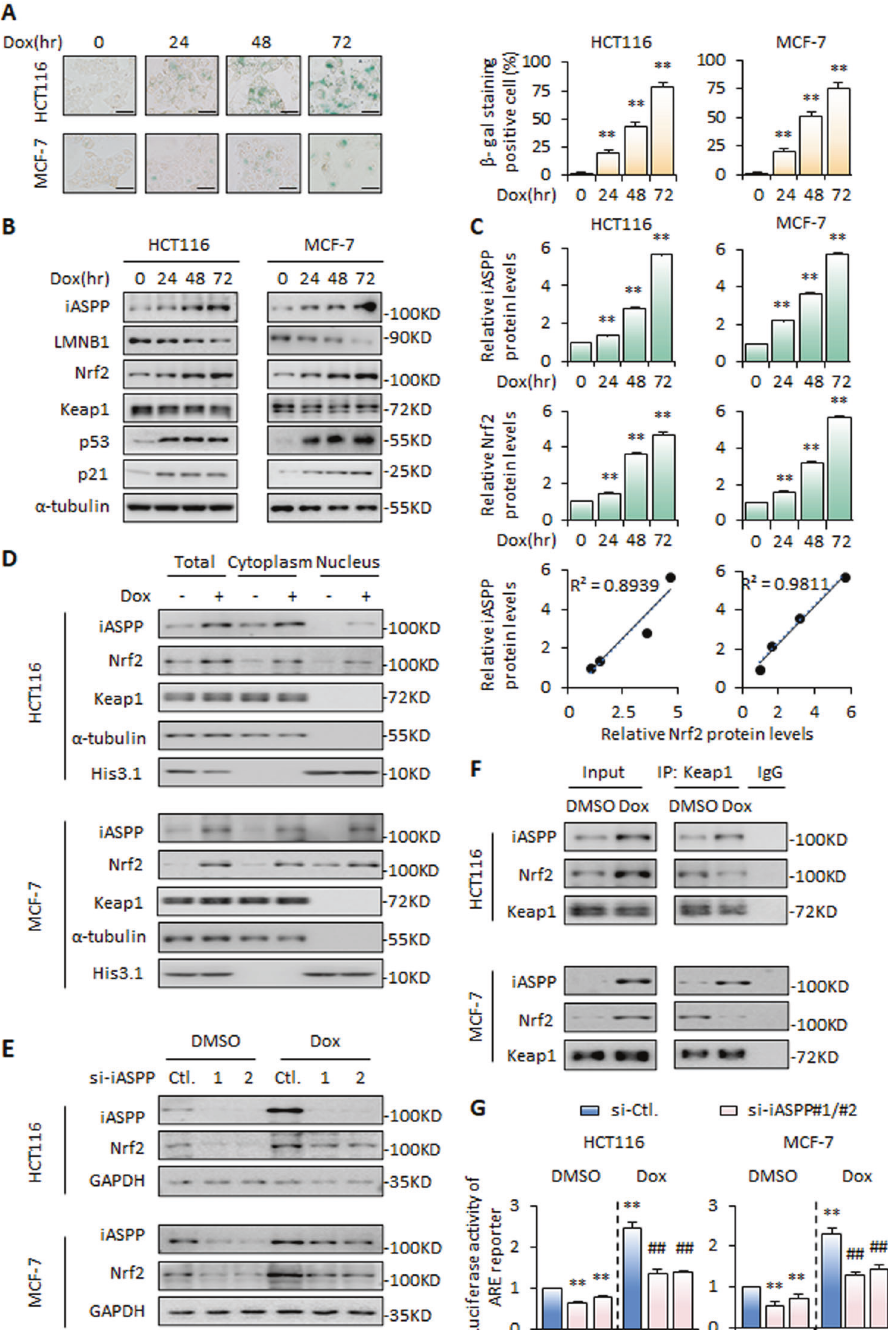
Fig. 1 iASPP is required for senescence-induced Nrf2 activation. A SA- β -gal staining was performed after triggering senescence in HCT116 and MCF-7 cells. Representative images were presented (left) and the quanti fi cation of SA- β -gal staining-positive cells was shown as a bar graph (right). Scale bar = 10 μ m. B , C Expression of iASPP, LMNB1, Nrf2, Keap1, p53, and p21 was determined by western blot in HCT116 and MCF-7 cells with the indicated treatments. Representative blots were presented and α -tubulin was used as an internal control ( B ). The quanti fi cation and association of iASPP and Nrf2 protein levels in HCT116 and MCF-7 cells were shown in dot blot ( C ). D Distribution of iASPP, Nrf2, and Keap1 in the nucleus and cytoplasm of HCT116 and MCF-7 cells under cellular senescence. E The protein expression levels of iASPP and Nrf2 were determined by western blot in HCT116 and MCF-7 cells after the indicated treatments. Representative blots were represented and GAPDH was used as an internal control. F The interaction of iASPP, Nrf2, and Keap1 was determined by immunoprecipitation (IP) assay of HCT116 and MCF-7 cells. G The luciferase activity of the ARE luciferase reporter in HCT116 and MCF-7 cells were determined after the indicated treatments. Quantitative data are presented as a bar graph. Values are mean ± SD from three independent experiments; ** P < 0.01, compared with DMSO ( A , C , G ); ## P < 0.01, compared with Dox-treated control ( G ).